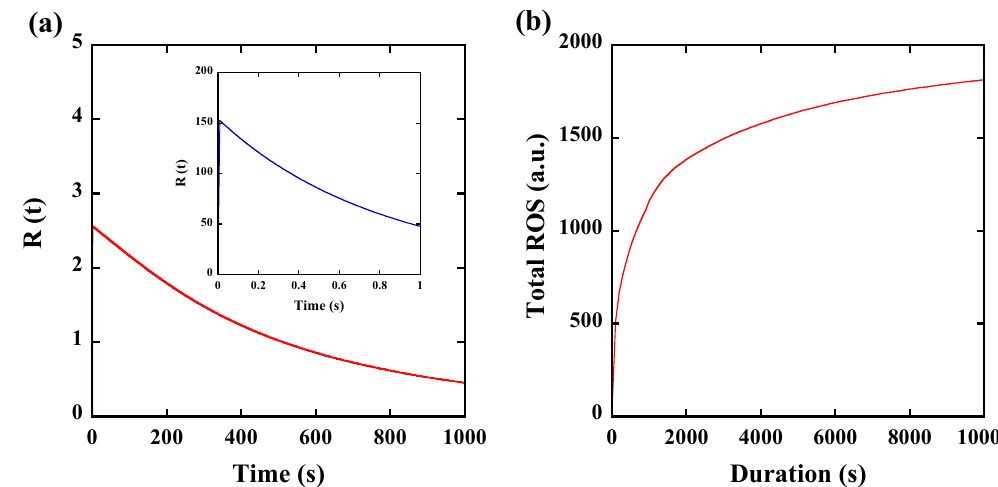
Figure 4. ( a ) Temporal behaviour of R(t) obtained at 0.01 mW/cm 2 with 1000 s (red curve) or 10 mW/cm 2 with 1 s (blue curve in the inset) at the irradiation wavelength of 265 nm. ( b ) Total amount of ROS as a function of irradiation duration at the same dose (265 nm, 10 mJ/cm 2